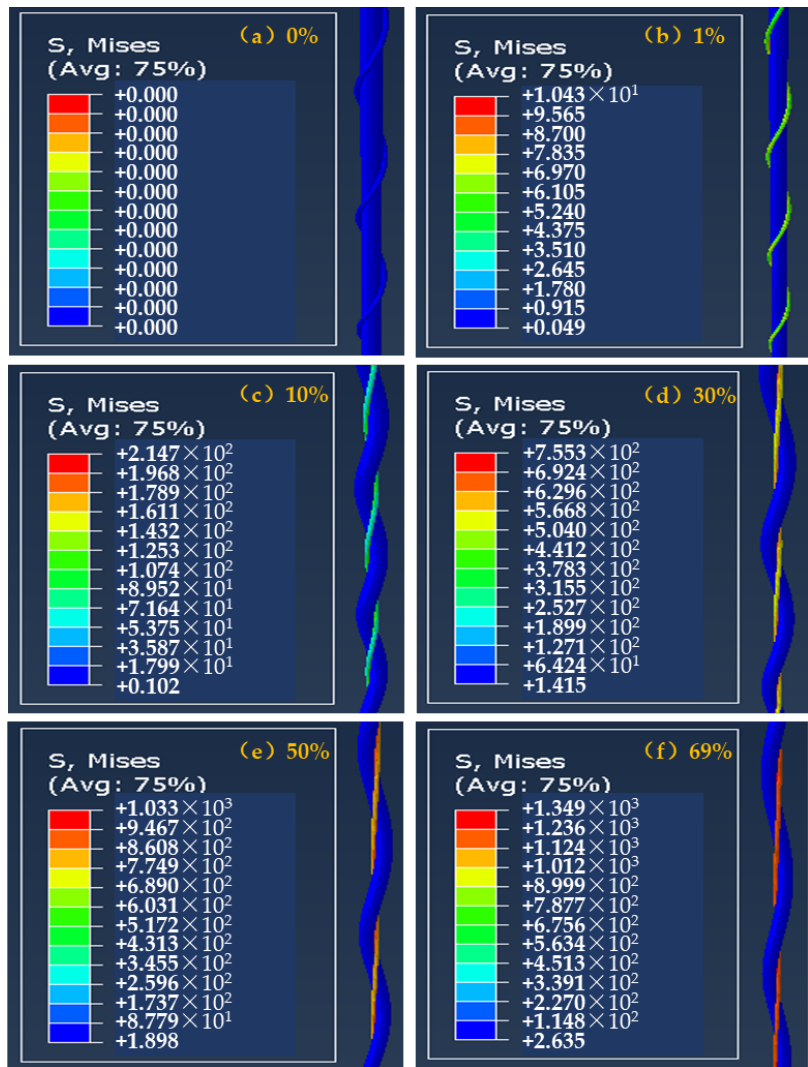
Figure 10. Mises stress distributions at different tensile strains of auxetic yarns: (a) 0%; (b) 1%; (c) 10%; (d) 30%; (e) 50%; (f) 69%.